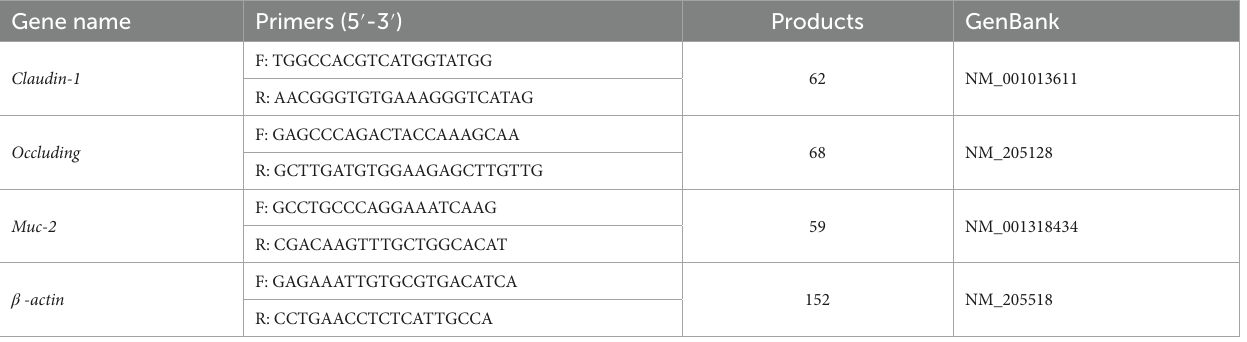
TABLE 2 Sequences of real-time PCR